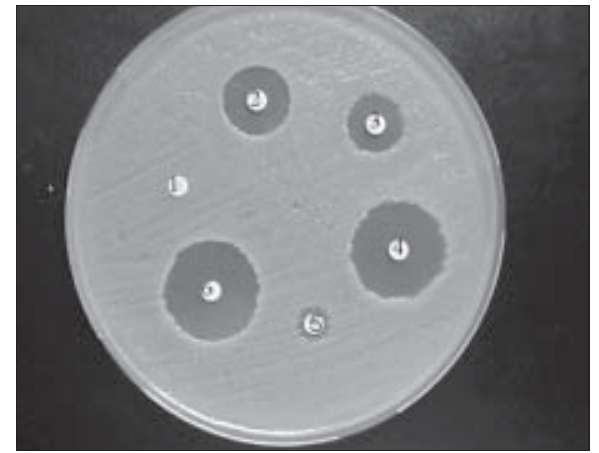
Figura 1 – Teste de adição de ácido clavulânico (Oxoid ® ) positivo em amostra de K. pneumoniae . Um aumento ≥ 5mm é observado nos halos dos antimicrobianos associados ao ácido clavulânico quando comparados com os antimicrobianos sem o ácido clavulânico. 1 = cefpodoxima; 2 = cefpodoxima + ácido clavulânico; 3 = ceftazidima; 4 = ceftazidima + ácido clavulânico; 5 = cefotaxima; 6 = cefotaxima + ácido clavulânico